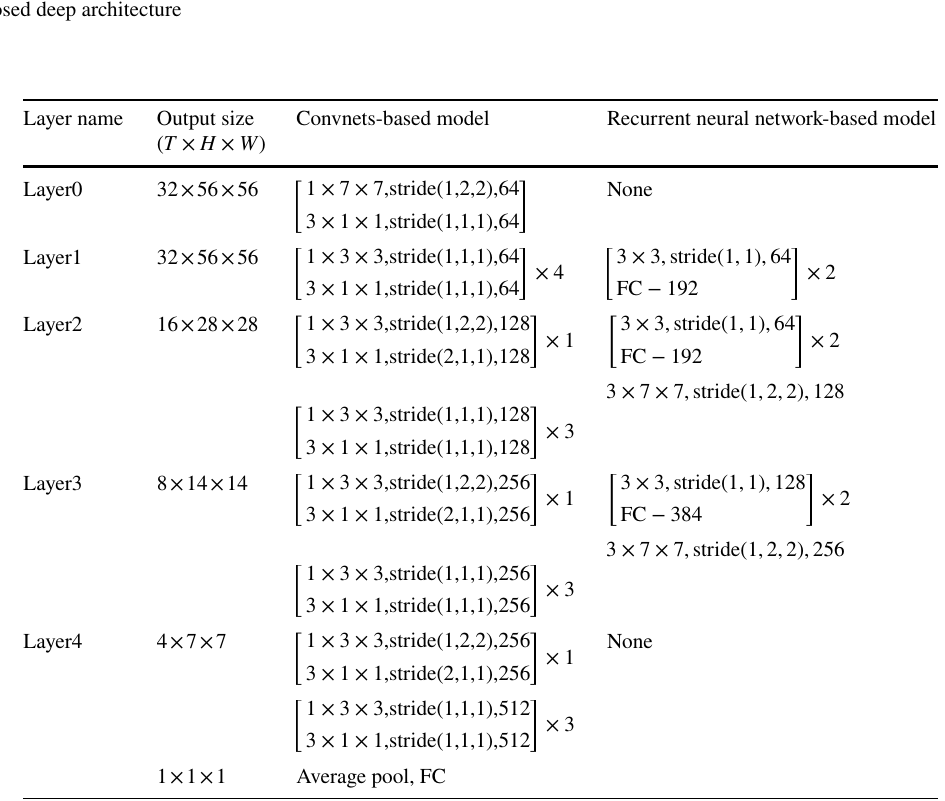
Fig. 1 The framework of the proposed deep architecture